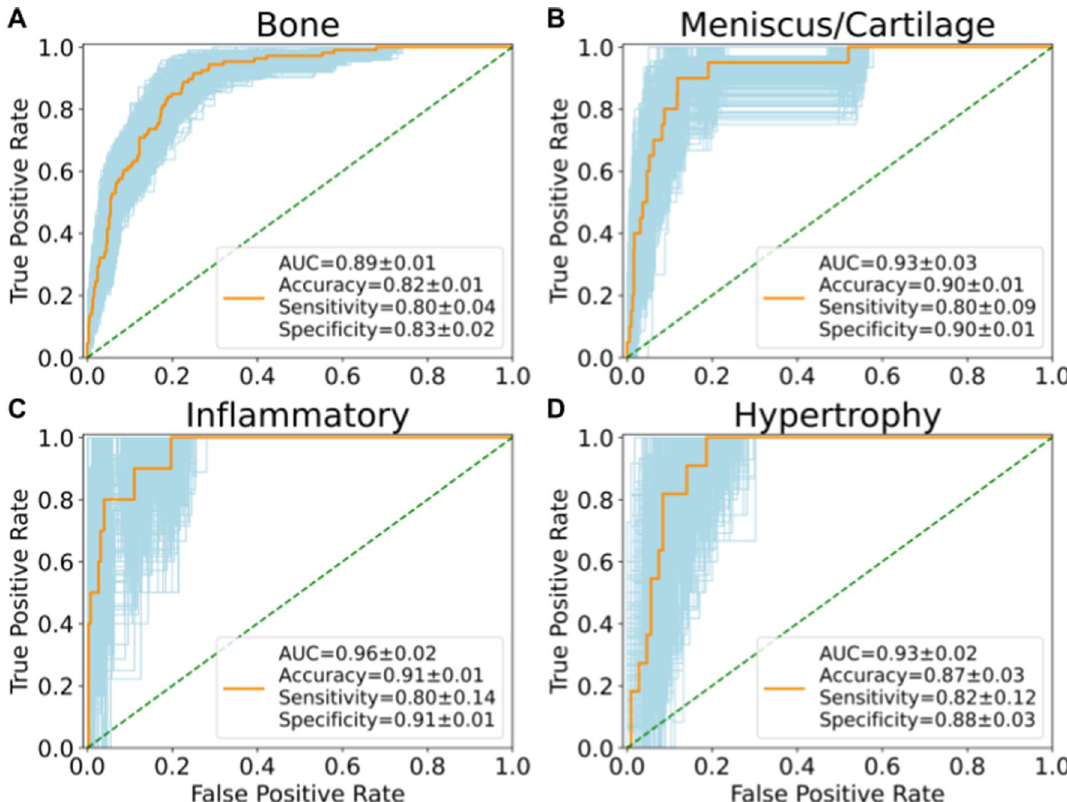
Figure 1. Receiver operating characteristic curves for knees from testing set (part of OAI subset graded by radiologists) with area under curve (AUC), accuracy, sensitivity, and specificity of the neural network phenotype classifiers. The AUC compared the predicted ROAMES phenotype from model prediction with the true phenotype assigned by the radiologists for each knee in the testing set. Metrics reported in mean ± standard deviation. Receiver operating characteristic curves produced using Python package Scikit-learn 29